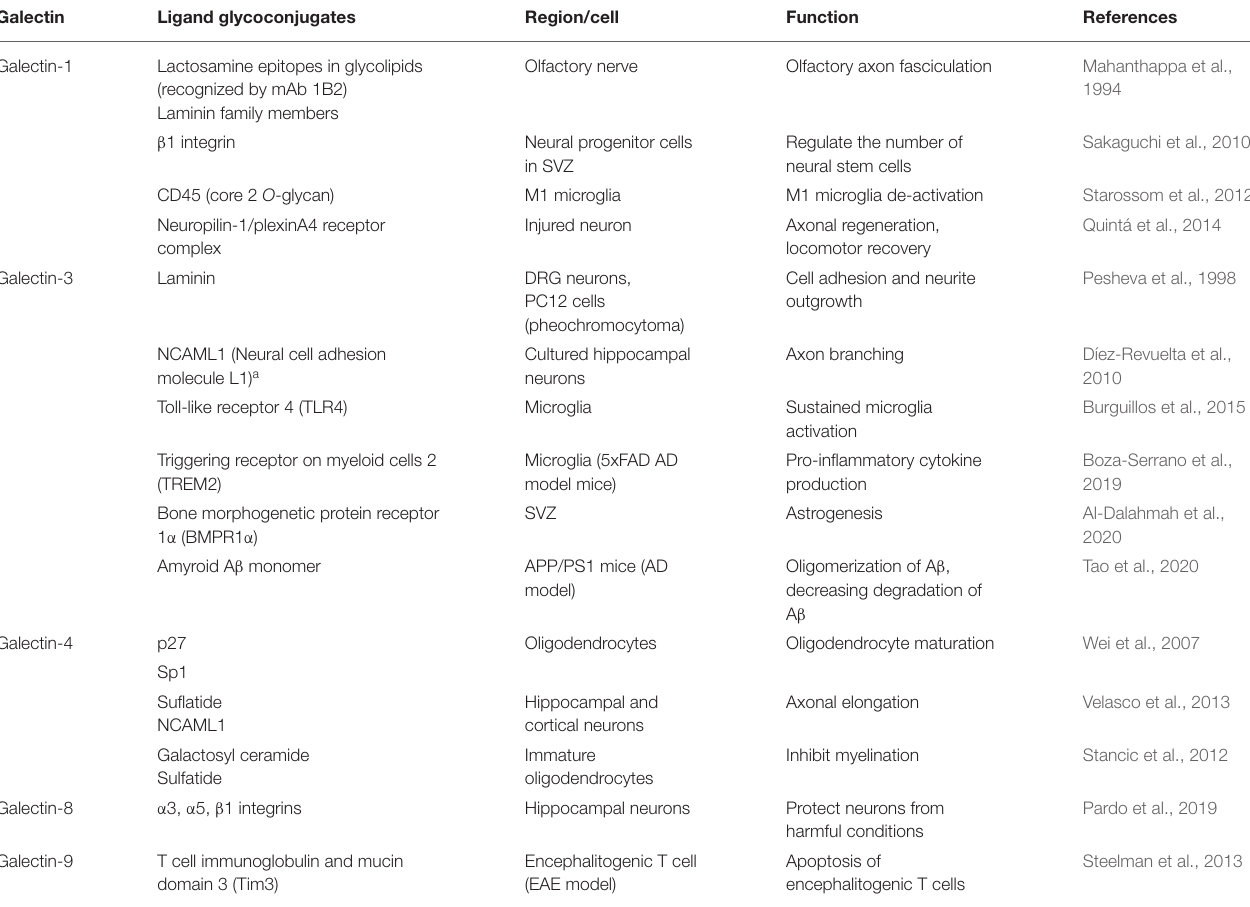
TABLE 1 | Ligands for galectins in the